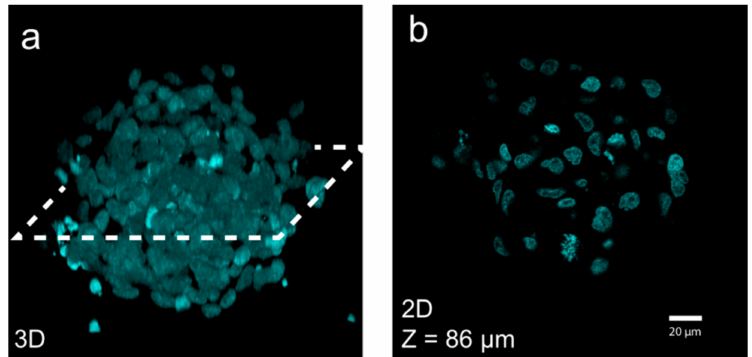
Figure 6. On-chip confocal imaging illustrates the strength with USW-based multi-cellular tumor spheroid (MCTS) culture